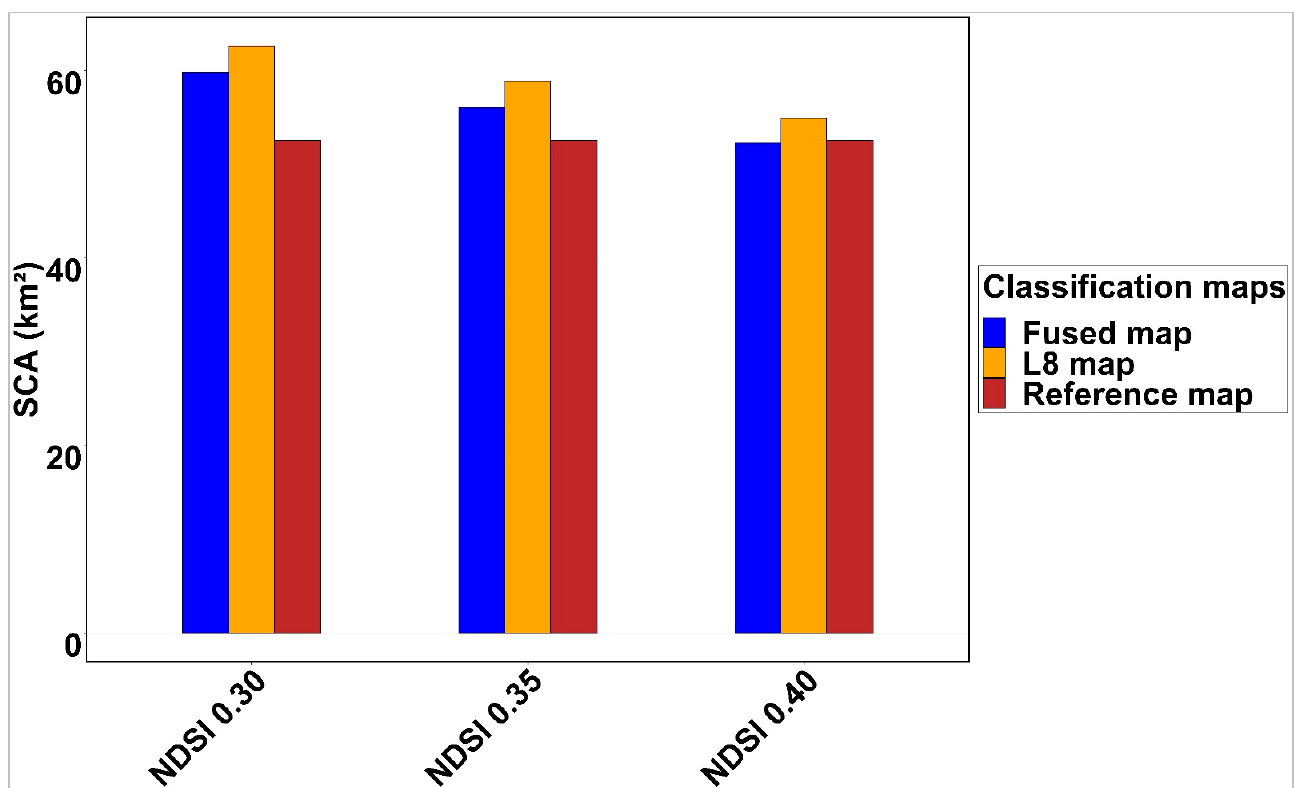
Figure 13. Comparison of snow cover area between the reference map and the S2, L8, and merged maps on 4 April 2016, for the study area.